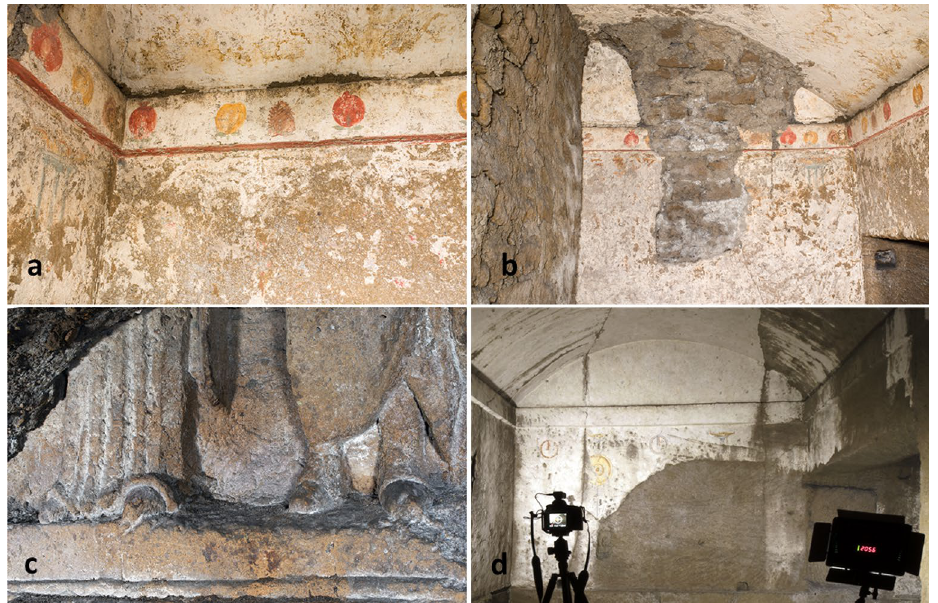
Figure 2. ( a ) Fragments of Greek burial chambers and ( b ) Ipogeo dei Melograni decorated with fruits frescoes along the walls ( c ) Togati - fragment of a high relief with a funeral farewell scene ( d ) chamber 8 in Fig. 11 with remains of frescoes on the North wall described by Neapolitan archaeologist Michele Ruggiero in